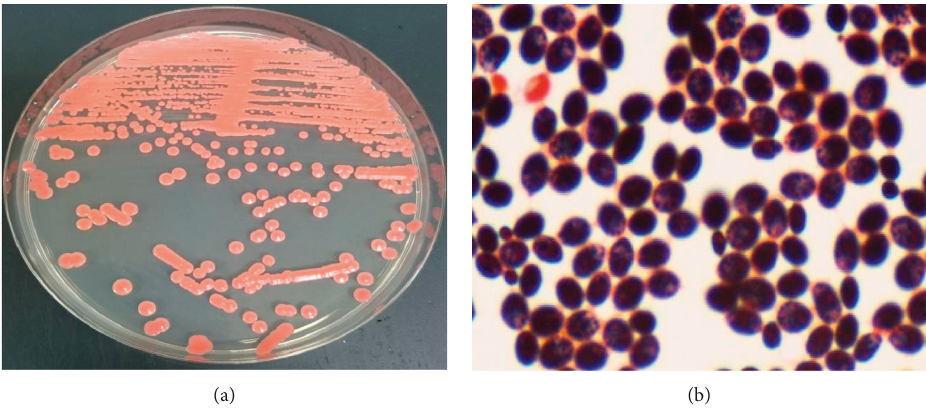
Figure 1: (a) Rhodotorula mucilaginosa colonies in Sabrouraud medium. (b) Gram stain of the isolate from blood culture. Table 1: Minimal inhibitory concentration and susceptibility pattern for Rhodotorula mucilaginosa isolated from a blood culture. Antifungal agents Minimum inhibitory concentration ( μ g/mL) Amphotericin B